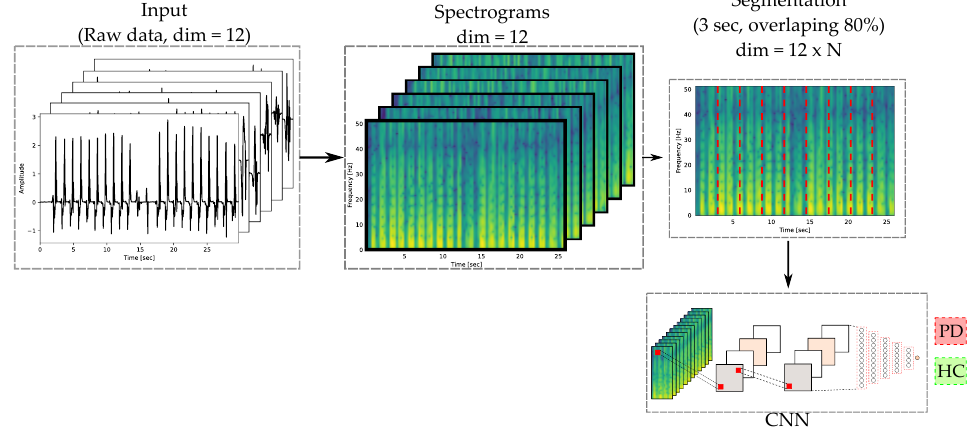
Figure 9. Methodology for the classification based on CNNs.